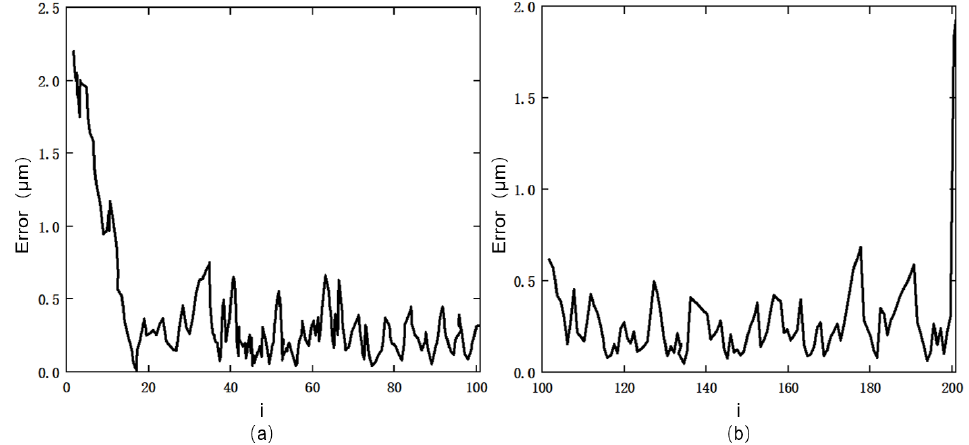
12 of 21 Figure 14. Signal fitting error plot (10 Hz): ( a ) ascending segment; ( b ) descending segment.